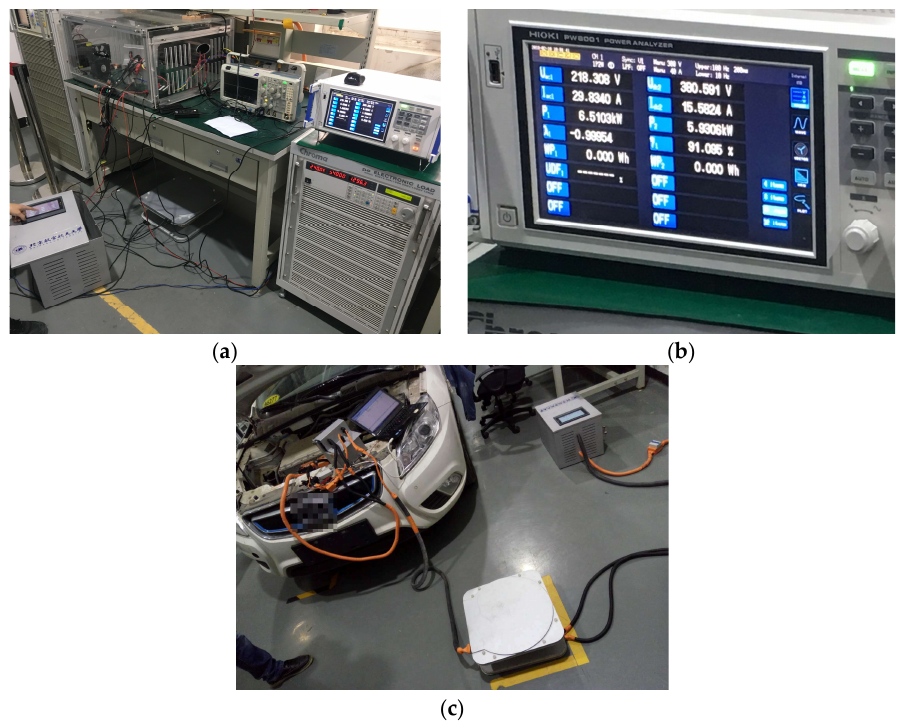
Figure 20. High-power test and loading test of wireless charging system. ( a ) High-power test environment; ( b ) test results; and ( c ) loading test process.